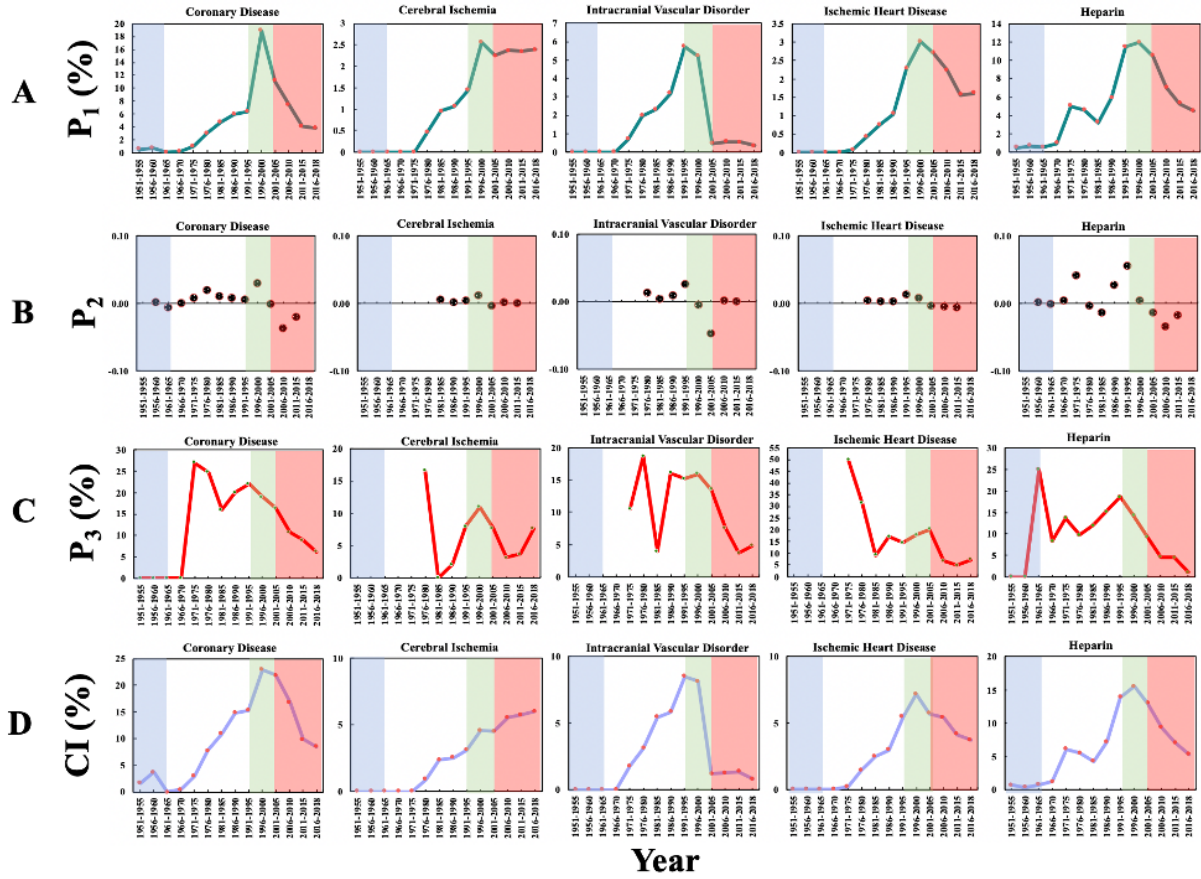
Figure 7. The 4 entitymetric indexes of the biomedical entities on cardiovascular diseases in the aspirin domain over time. The background colors show the 4 phases of aspirin